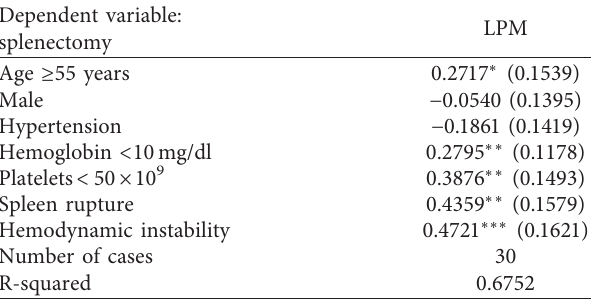
Table 2: Estimates of the linear probability model (LPM) for